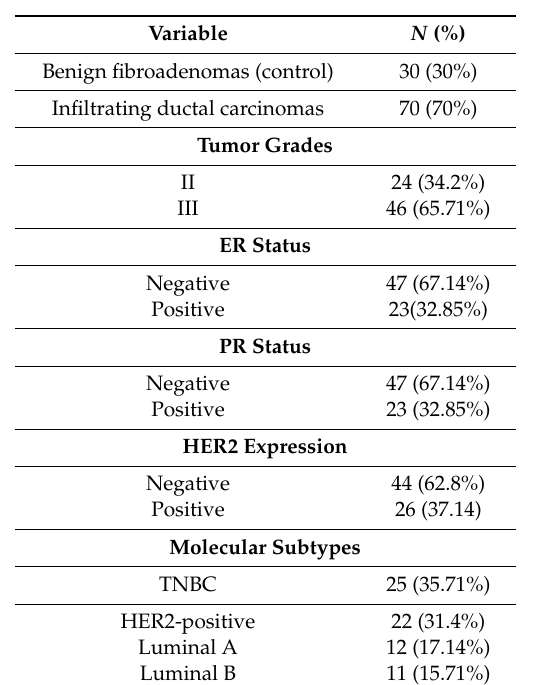
Table 1. Clinico-pathological data of breast tissue samples included in the